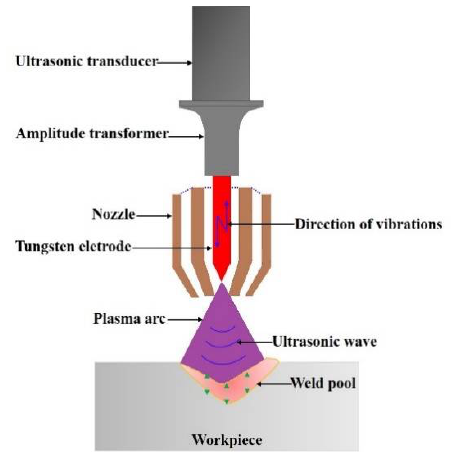
Figure 1. Schematic illustration of the ultrasonic-assisted plasma arc welding process.